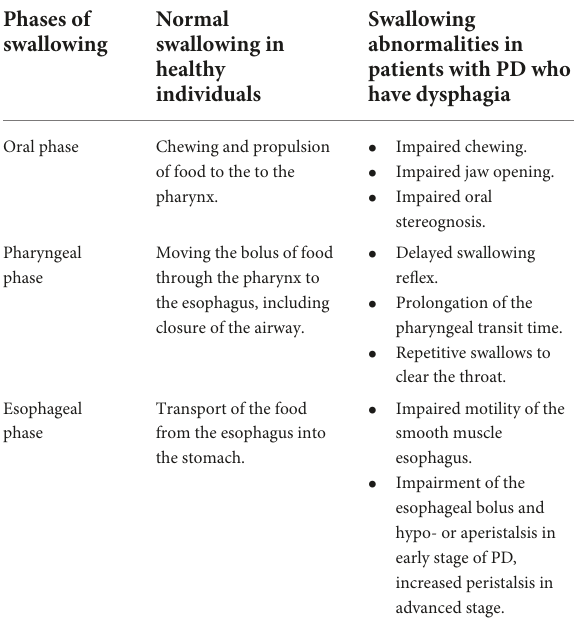
TABLE 1 Physiology of normal swallowing in healthy individuals and pathophysiology of dysphagia in patients with Parkinson’s disease (PD) according to phases of